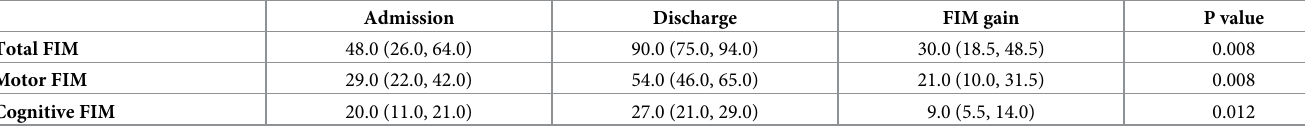
Table 3. Changes in total, motor and cognitive FIM between admission and discharge.